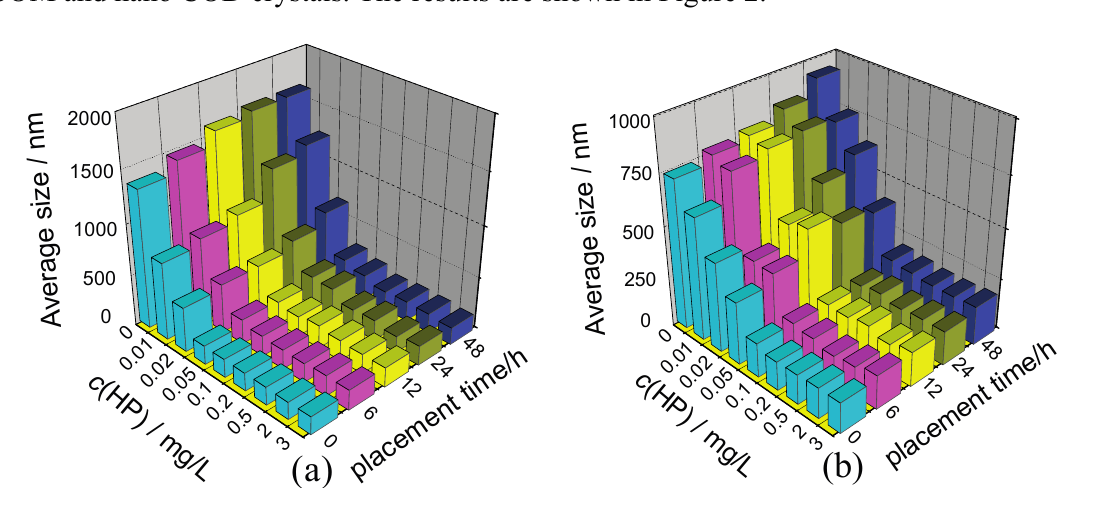
Figure 2. Effect of c (HP) and placement time ( t ) on the mean diameter of nano COM and nano COD crystals. ( a ) Nano COM; ( b ) Nano